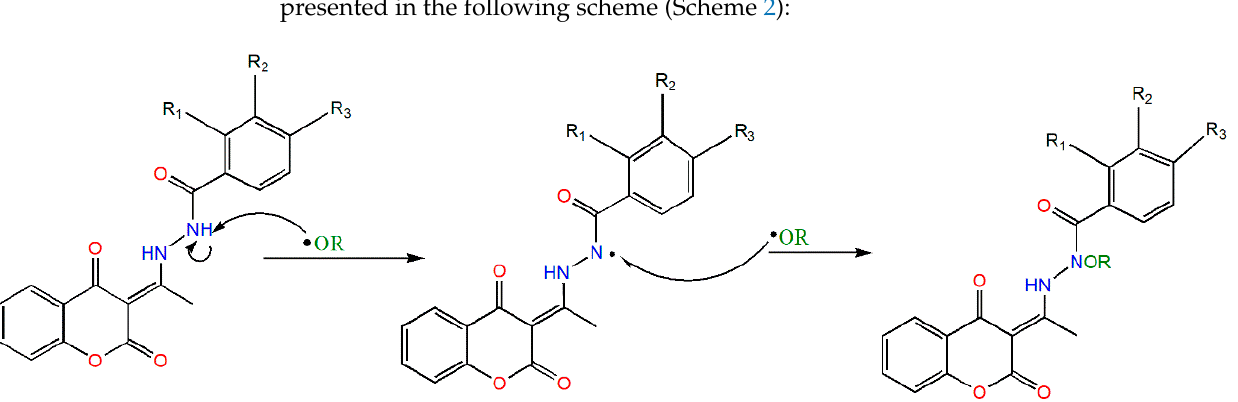
Table 2. Predicted pharmacokinetic parameters of investigated compounds by SwissADME